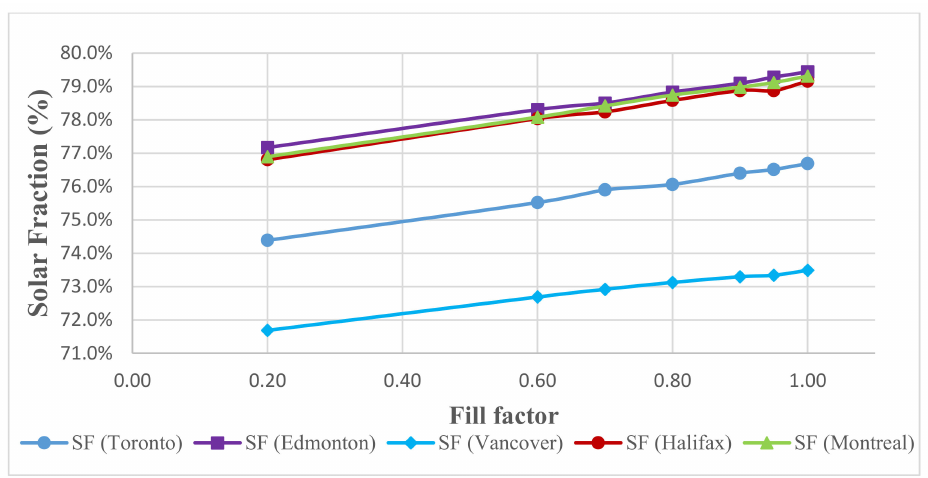
Figure 15. MCPVT-HP PV fill factor sensitivity analysis for Toronto and Edmonton. To study climatic effects on overall system efficiency, all systems are simulated at 45 ◦ tilt angle in five different Canadian cities with different annual ambient